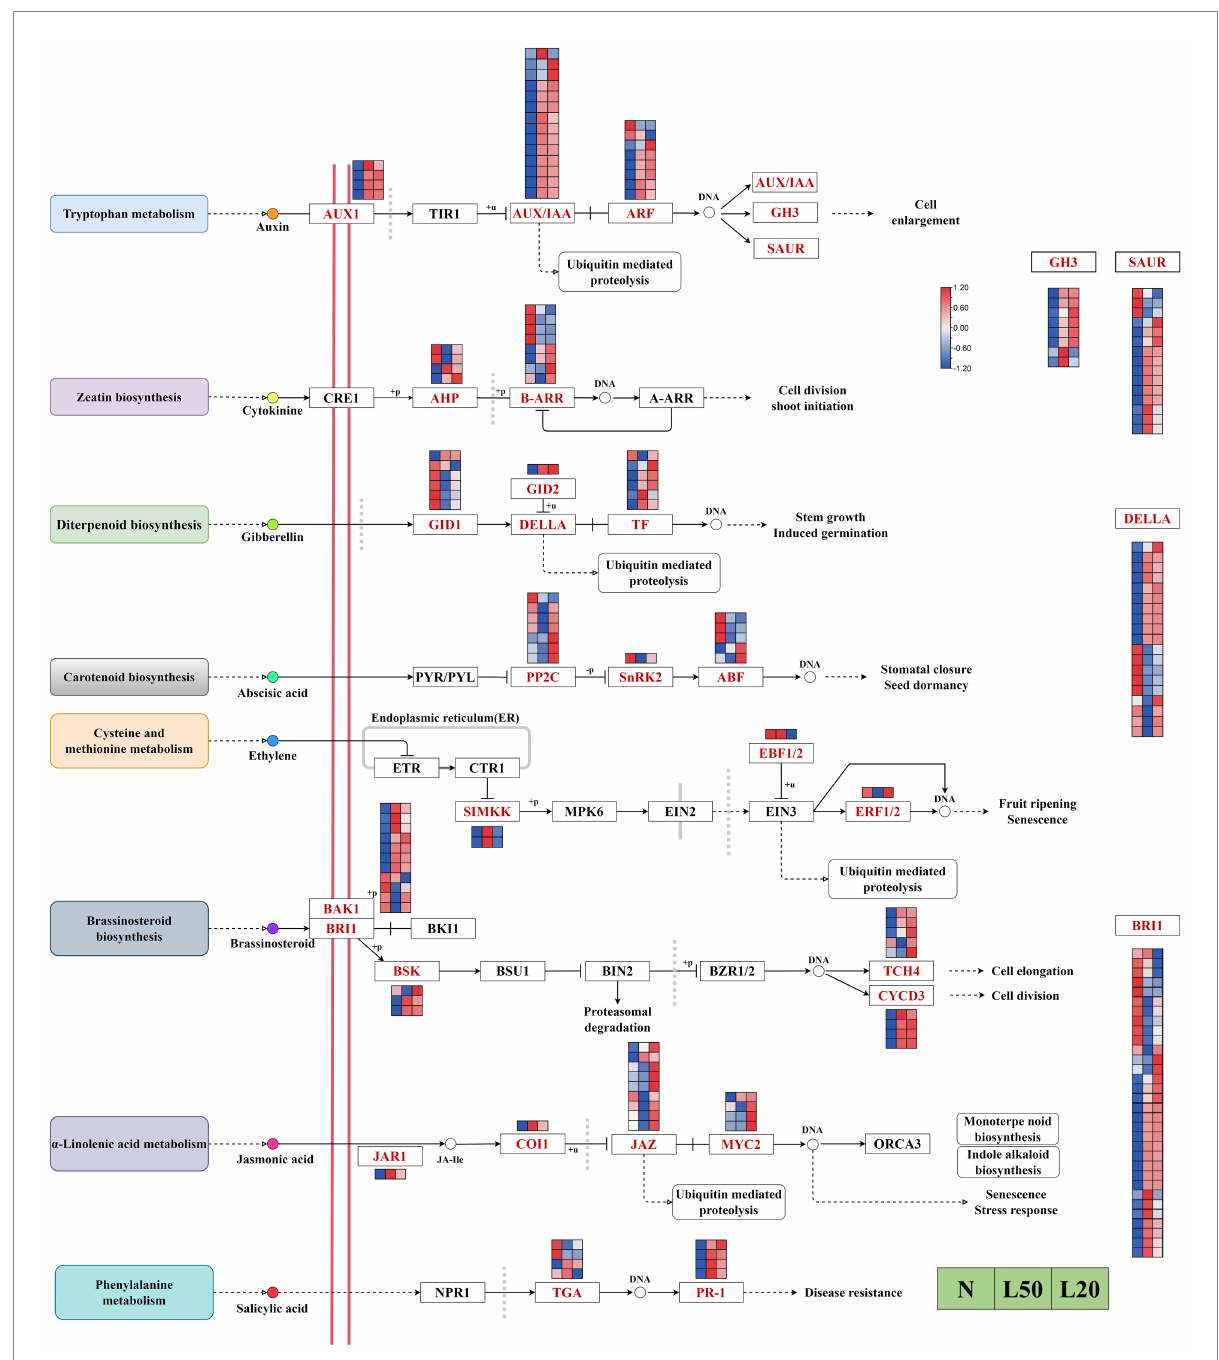
FIGURE 8 Analysis of DEGs related to phytohormone signaling pathways. The color scale from Min (blue) to Max (red) refers to the expression value from low to high. N: natural sunlight. L50: 50% sunlight to go through. L20: 20% sunlight to go through. AUX1, auxin influx carrier (AUX1 LAX family); TIR1, transport inhibitor response 1; AUX/IAA, auxin-responsive protein IAA; ARF, auxin response factor; GH3, auxin responsive GH3 gene family; SAUR, SAUR family protein; CRE1, arabidopsis histidine kinase 2/3/4 (cytokinin receptor); AHP, histidine-containing phosphotransfer protein; B-ARR, two-component response regulator ARR-B family; A-ARR, two-component response regulator ARR-A family; GID1, gibberellin receptor GID1; GID2, F-box protein GID2; DELLA, DELLA protein; TF, phytochrome-interacting factor 4; PYL/PYL, abscisic acid receptor PYR/PYL family; PP2C, protein phosphatase 2C; SNRK2, serine/threonine-protein kinase SRK2; ABF, ABA responsive element binding factor; ETR, ethylene receptor; CTR1, serine/threonine-protein kinase CTR1; SIMKK, mitogen-activated protein kinase 4/5; MPK6, mitogen-activated protein kinase 6; EIN2, ethylene-insensitive protein 2; EBF1/2, EIN3-binding F-box protein; EIN3, ethylene-insensitive protein 3; ERF1/2, ethylene-responsive transcription factor 1; BAK1, brassinosteroid insensitive 1-associated receptor kinase 1; BRI1, protein brassinosteroid insensitive 1; BKI1, BRI1 kinase inhibitor 1; BSK, BR-signaling kinase; BSU1, serine/threonine-protein phosphatase BSU1; BIN2, protein brassinosteroid insensitive 2; BZR1/2, brassinosteroid resistant 1/2; TCH4, xyloglucan: xyloglucosyl transferase TCH4; CYCD3, cyclin D3, plant; JAR1, jasmonic acid-amino synthetase; COI1, coronatine-insensitive protein 1; JAZ, jasmonate ZIM domain-containing protein; MYC2, transcription factor MYC2; ORCA3, AP2-domain DNA-binding protein ORCA2/3; NPR1, regulatory protein NPR1; TGA, transcription factor TGA; PR1, pathogenesis-related protein